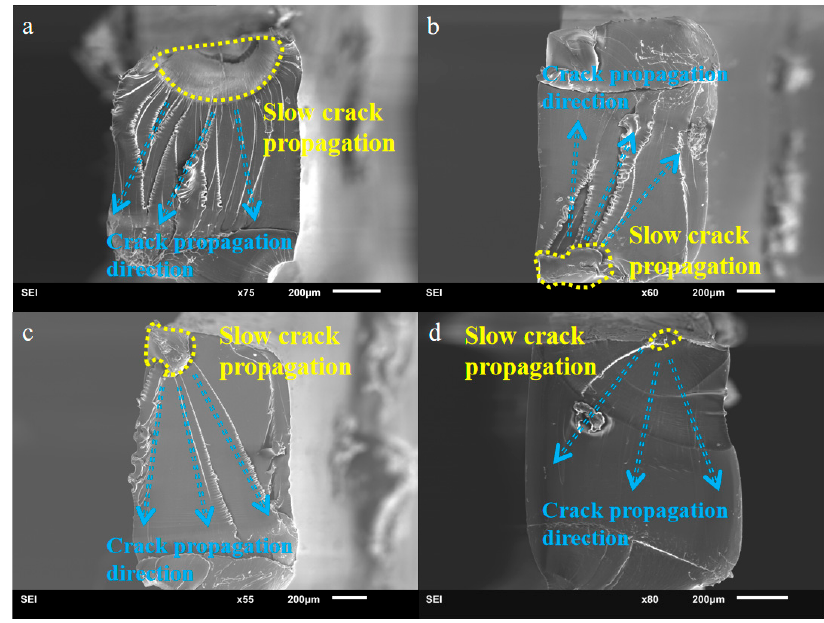
Figure 11. Overviews of the fracture surfaces at different stress, where the yellow boundaries indicate the slow crack propagation regions and the red arrows indicate the failure propagation paths. ( a ) 13.08 MPa. Nf = 1 × 10 6 cycles, ( b ) 15.72 MPa. Nf = 3 × 10 5 cycles, ( c ) 17.08 Mpa. Nf = 1 × 10 5 cycles, and ( d ) 23.04 Mpa. Nf = 3 × 10 3 cycles.